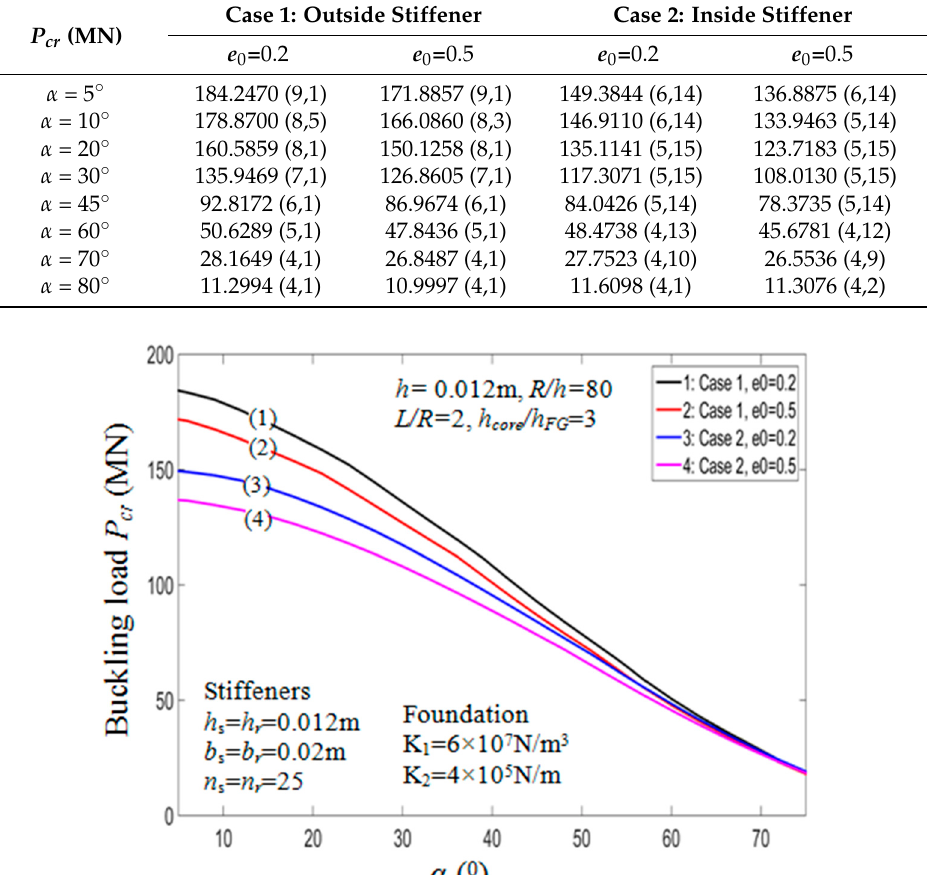
Figure 6. Effects of semi-vertex angle α on critical load P cr ( k 2 = k 3 = k = 1). Case 1: Outside stiffener; Case 2: Inside stiffener.